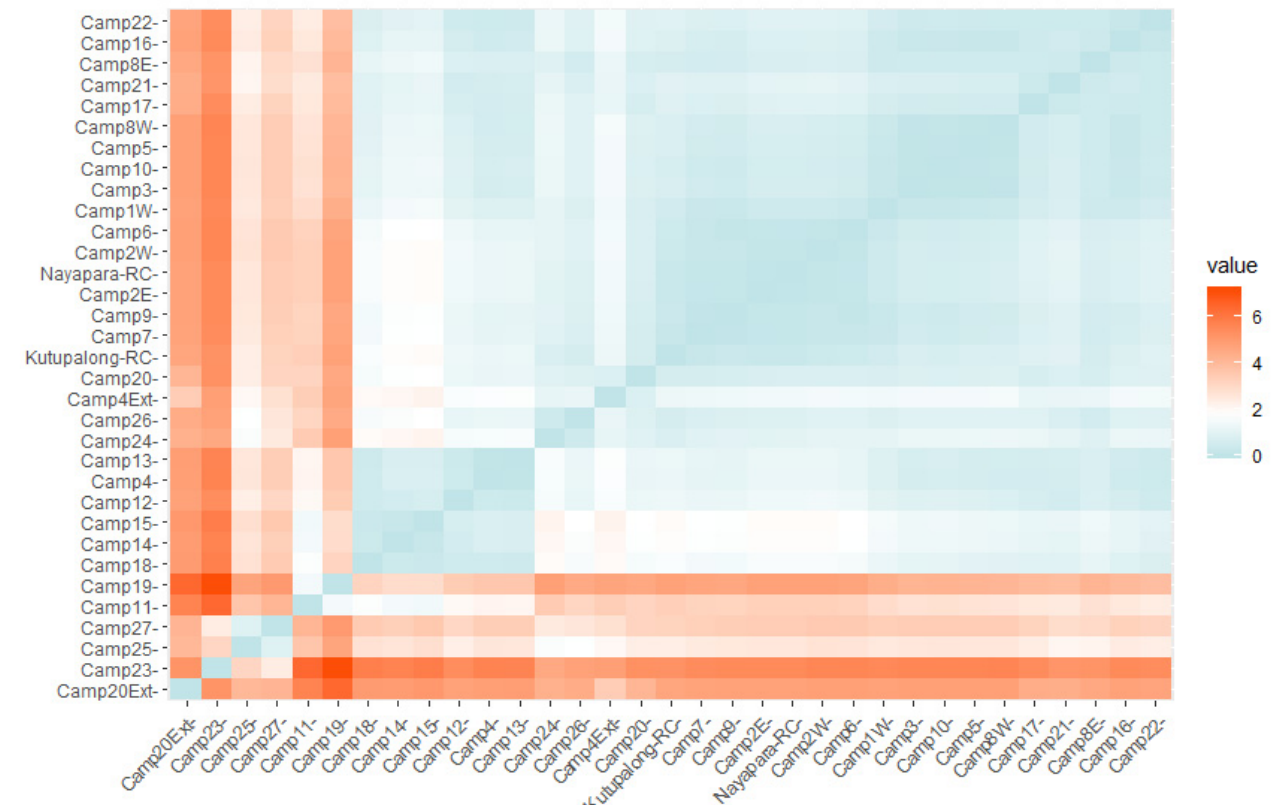
Figure 9. Heat map of PCGA dissimilarity, by all thirty-four Rohingya Refugee Camps, from 2017–2019. A higher value represents significant dissimilarity, and the lower value represents a dataset that appears to be reasonably similar.